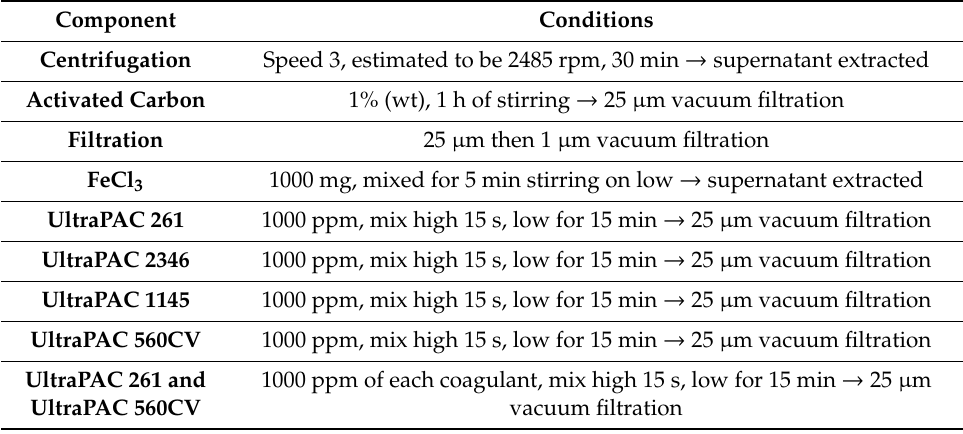
Table 1. Experimental conditions for treating produced